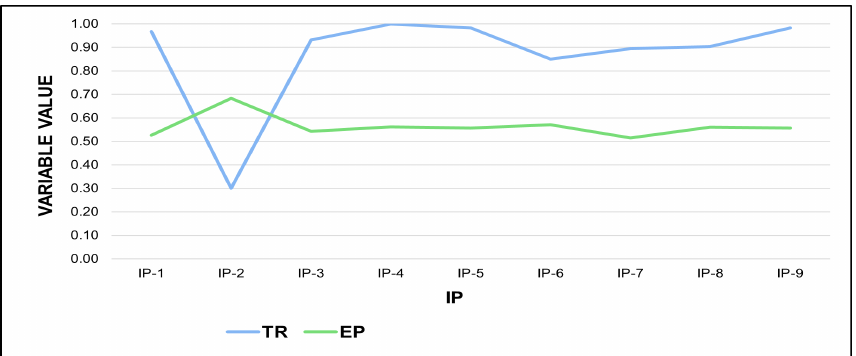
Figure 9. Variable vulnerabilities. The relationship between these variables is inversely proportional. When the number of references is low, the vulnerability maintains a high ep since there is a lack of knowledge about the containment and mitigation of the vulnerability.